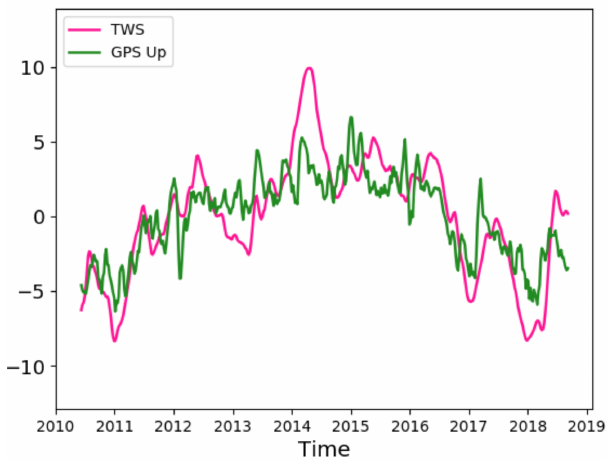
Figure 15. Time components of the second SVD of the residuals of the variable pair (monthly values) TWS (magenta line) and Up coordinate (green line).